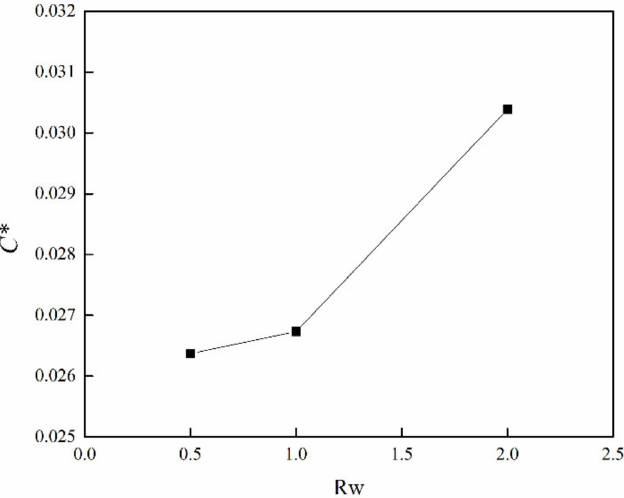
Figure 13. Relative concentration per unit area C* on the vertical plane (y = 0) with different aspect ratio